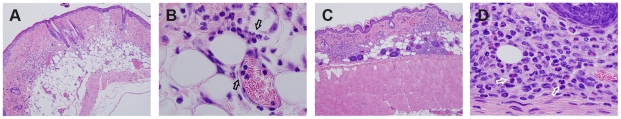
Inflammatory response of naïve and immune mice to sand fly bites on normal skin.Inflammatory response detected 48 hours after exposure to the bite of L. longipalpis sand flies on naïve mice (A and B) and immune mice (C and D). Black arrows indicate neutrophils and white arrows eosinophils. Hematoxylin-eosin stain. Magnification, 200x in (A and C), 1000X in (B and D).